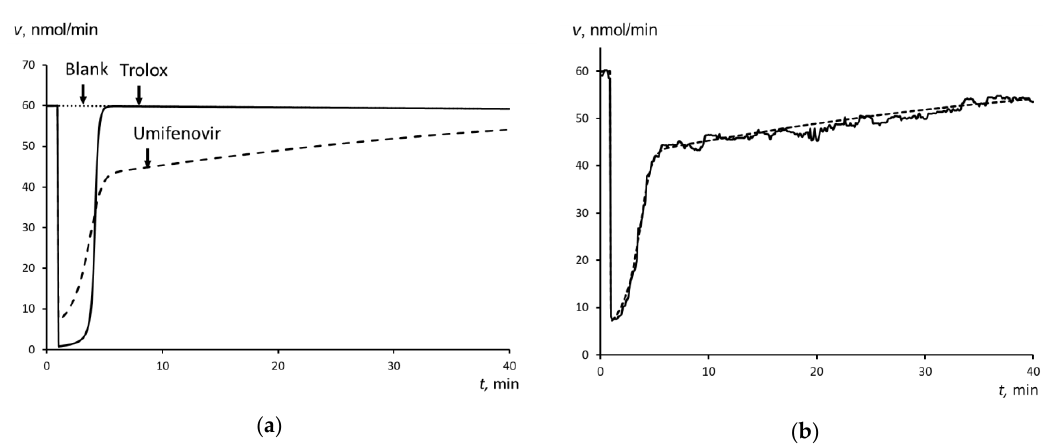
Figure 5. ( a ) The simulated chemiluminescence plots, spot line—ABAP without antioxidant (blank), dotted line—the chemiluminogram of Umifenovir, solid line—the chemiluminogram of Trolox; ( b ) The experimental (solid line) and simulated (dashed line) plots for Umifenovir.